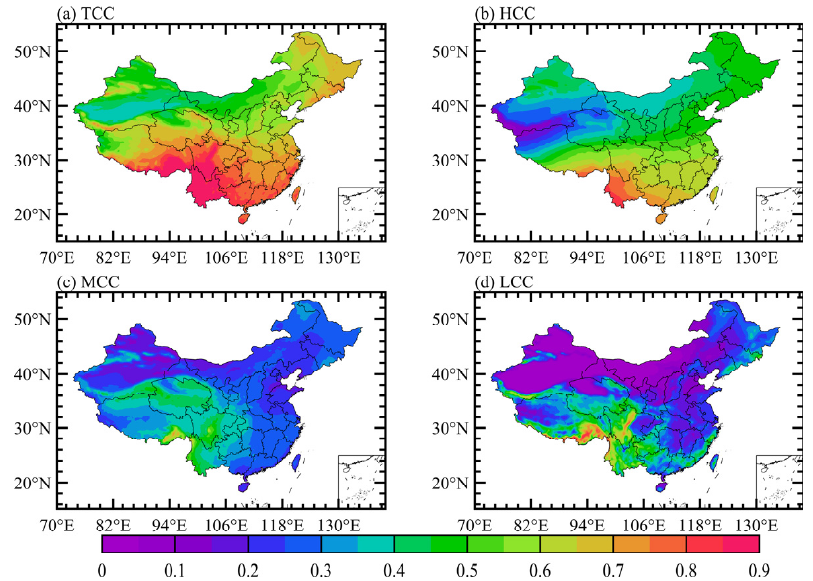
Figure 4. Spatial distribution of monthly average ( a ) total cloud cover (TCC), ( b ) high-cloud cover (HCC), ( c ) medium-cloud cover (MCC) and ( d ) low-cloud cover (LCC) over China during the summers of 1979–2020.